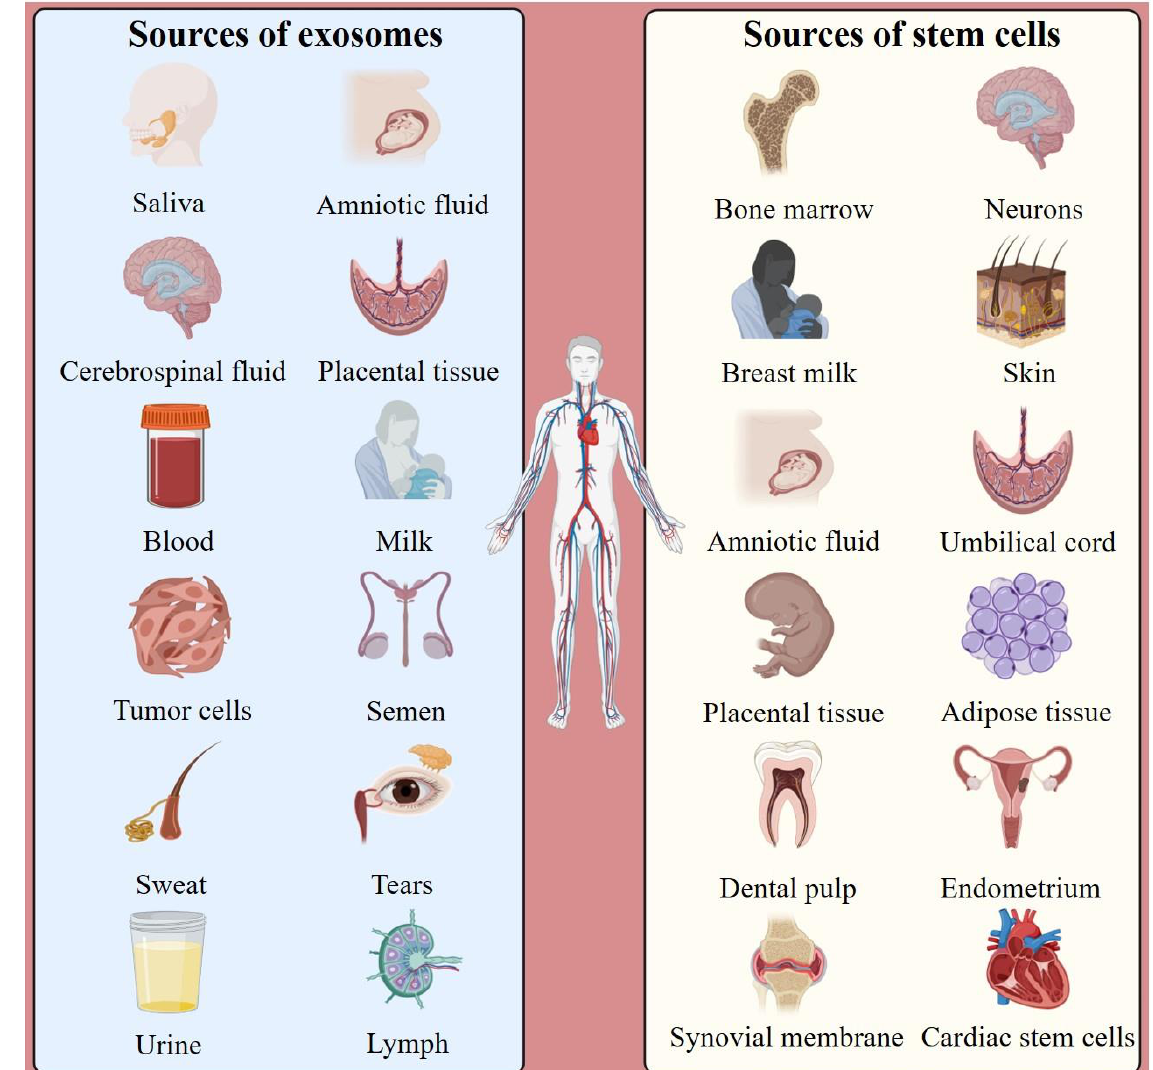
Figure 2. Sources of exosomes and stem cells. Exosomes have been detected in almost all body fluids, including, amniotic fluid, urine, cerebrospinal fluid, blood, serum, breast milk, malignant ascites, saliva, bile, etc. MSCs are non-hematopoietic, multipotent, adult stem cells which can be isolated from bone marrow, umbilical cord, placental tissue, adipose tissue, dental pulp, neurons, skin, breast milk, etc.